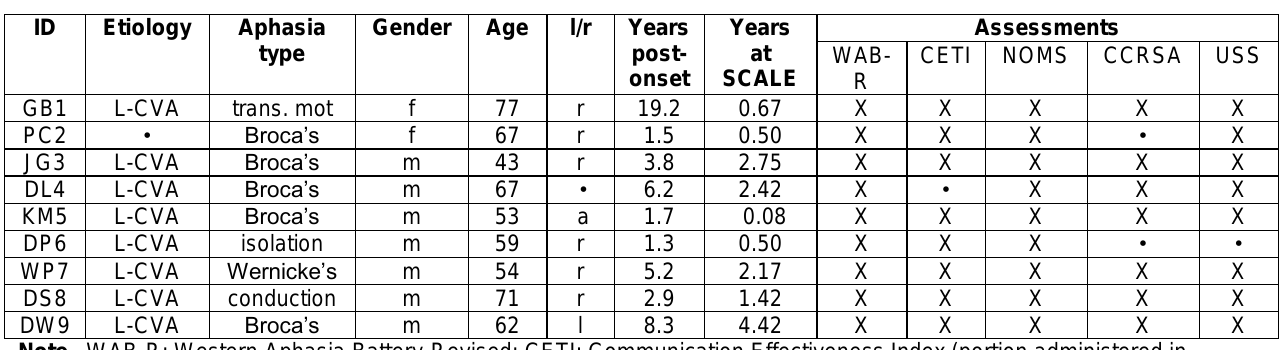
Table 1. Subjects at SCALE Center ( n = 9)